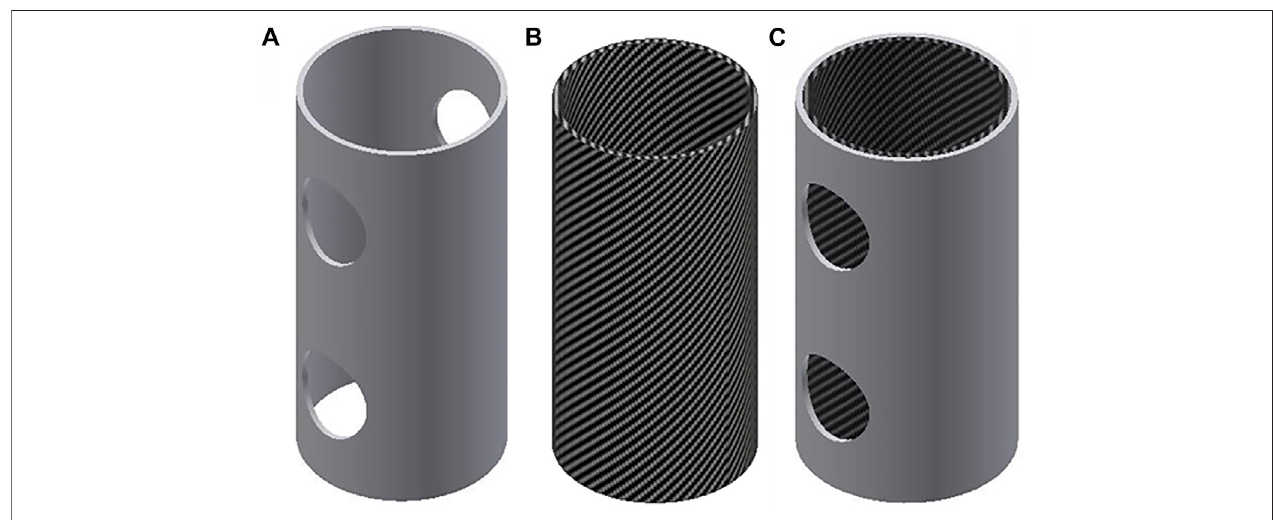
FIGURE 2 | Three kinds of tubes: (A) open-hole AL, (B) CFRP, and (C) hybrid.